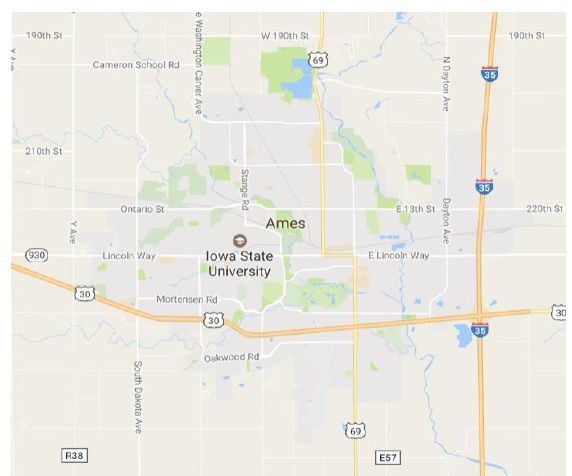
Figure 2. The City of Ames area,